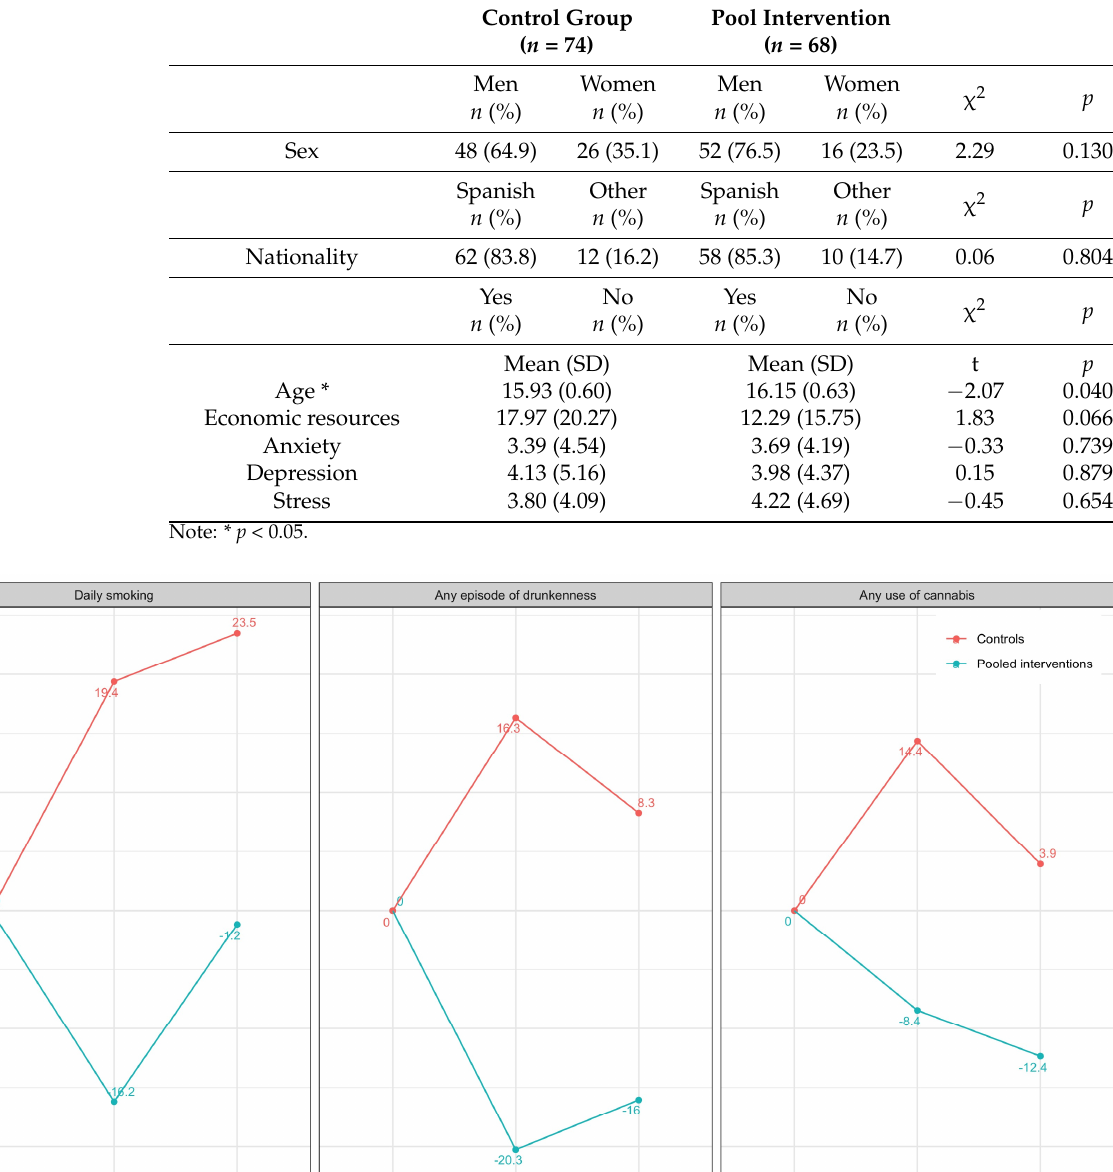
Table 2. Baseline sociodemographic and clinical characteristics of experimental and control groups